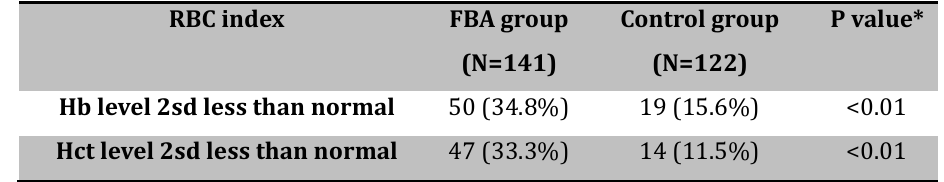
Table 3. Incidence of anemia according to hemoglobin and hematocrit level considering age matches nomogram among patients with foreign body aspiration and control